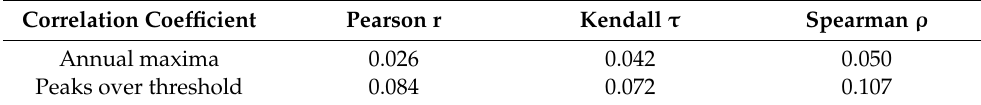
Table 4. Correlation coefficients between extreme rainfall and tide level series.